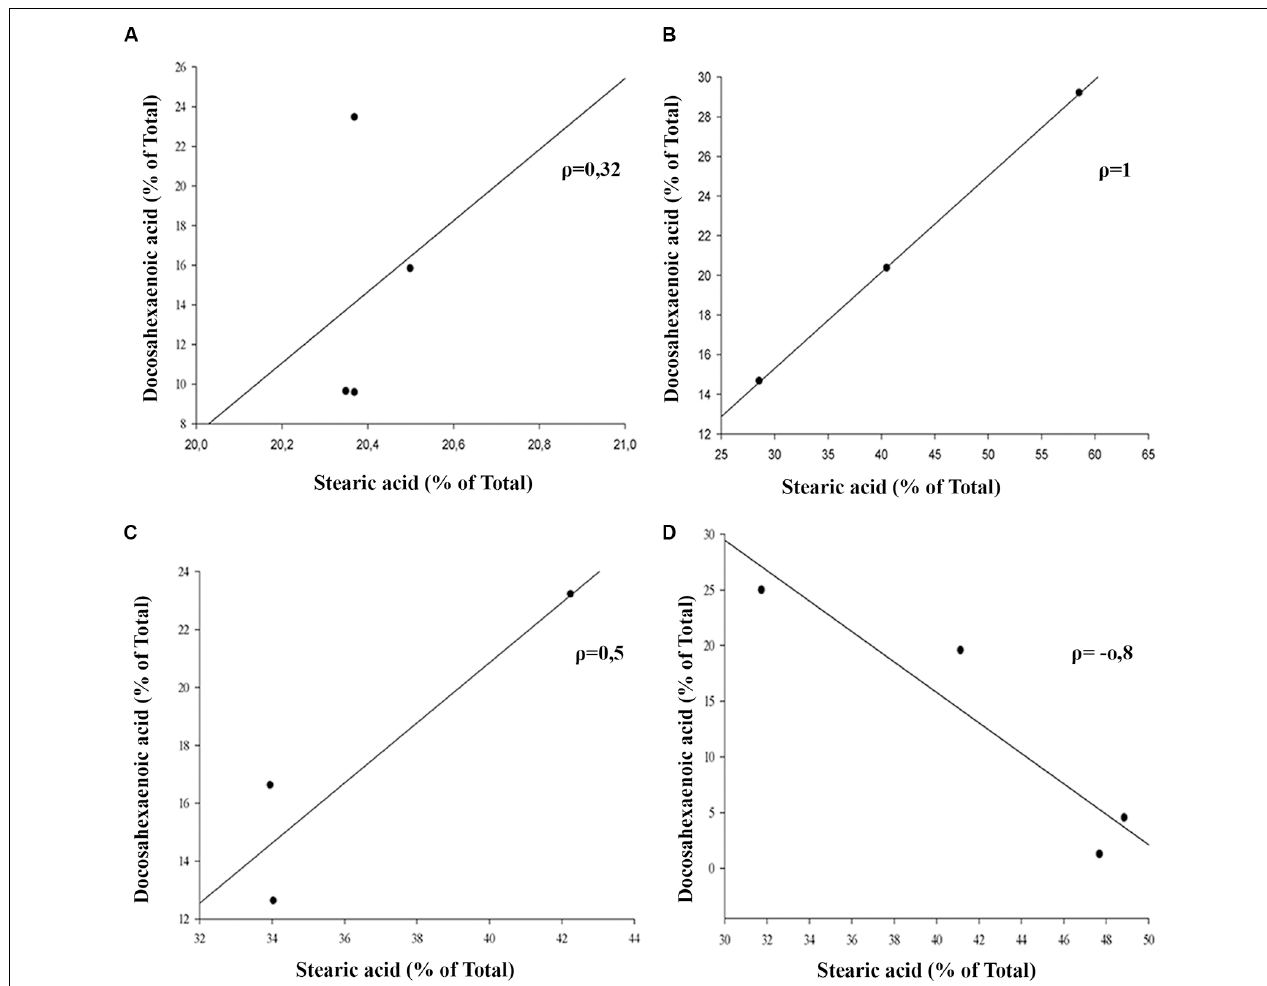
FIGURE 5 | Linear correlation analysis between stearic and docosahexaenoic acid in light-treated retinas. (A) Control animals maintained in DD. (B–D) Animals maintained for 4, 6 and 8 days at constant light, respectively. ρ : pearson correlation coefficient, n = 1 animal/group from three independent